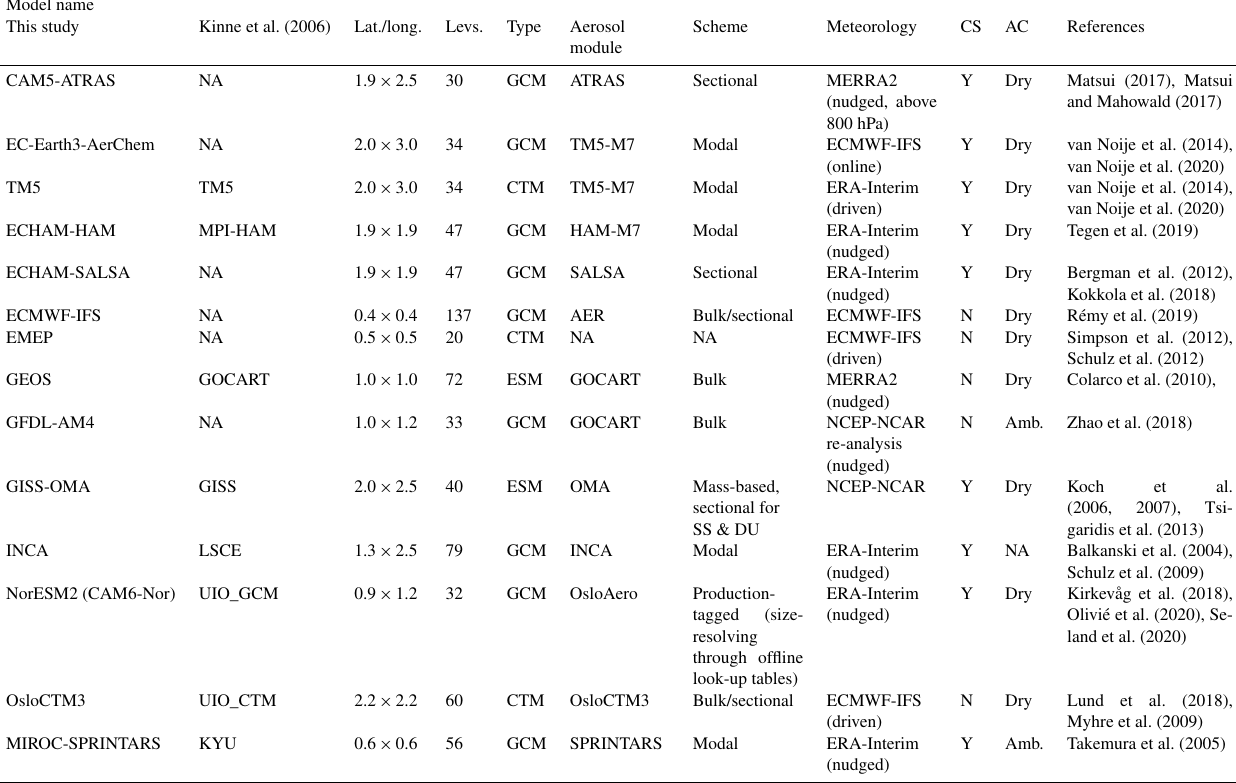
Table 2. Models used in this study including relevant additional information. Kinne et al. (2006): name of model in Kinne et al. (2006) (see Table 2 therein, where applicable). Lat./long.: horizontal grid resolution. Levs.: number of vertical levels. Type: type of atmospheric model. Aerosol module: name of aerosol module. Scheme: type of aerosol scheme. Meteorology: meteorological data set used for the